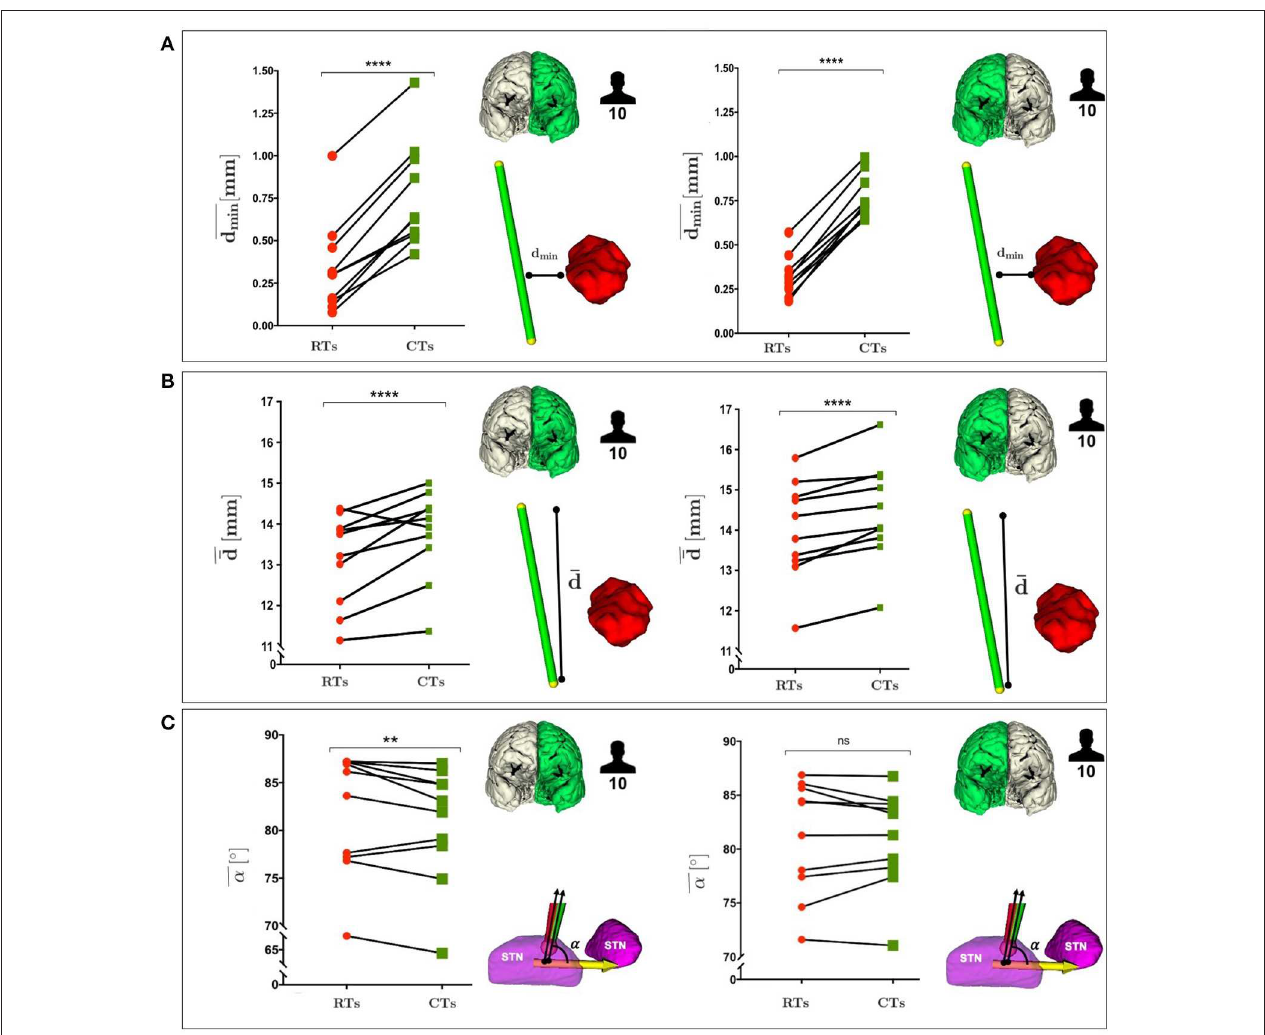
FIGURE 5 | (A) Comparison between RTs and CTs, reported for the 10 subjects, in terms of the mean value of the d min , calculated over the best trajectory of all the EP i , from all critical AOs of left and right hemisphere. (B) Comparison between RTs and CTs, reported for the 10 subjects, in terms of the mean value of the ¯ d , calculated over the best trajectory of all the EP i , from all critical AOs of left and right hemisphere. (C) Comparison between RTs and CTs, reported for the 10 subjects, in terms of the mean value of the STN entry angle, α , calculated over the best trajectory of all the EP i , from all critical AOs of left and right hemisphere. p -values were calculated using Wilcoxon matched-pairs signed rank test (** p ≤ 0.01, **** p ≤ 0.0001).